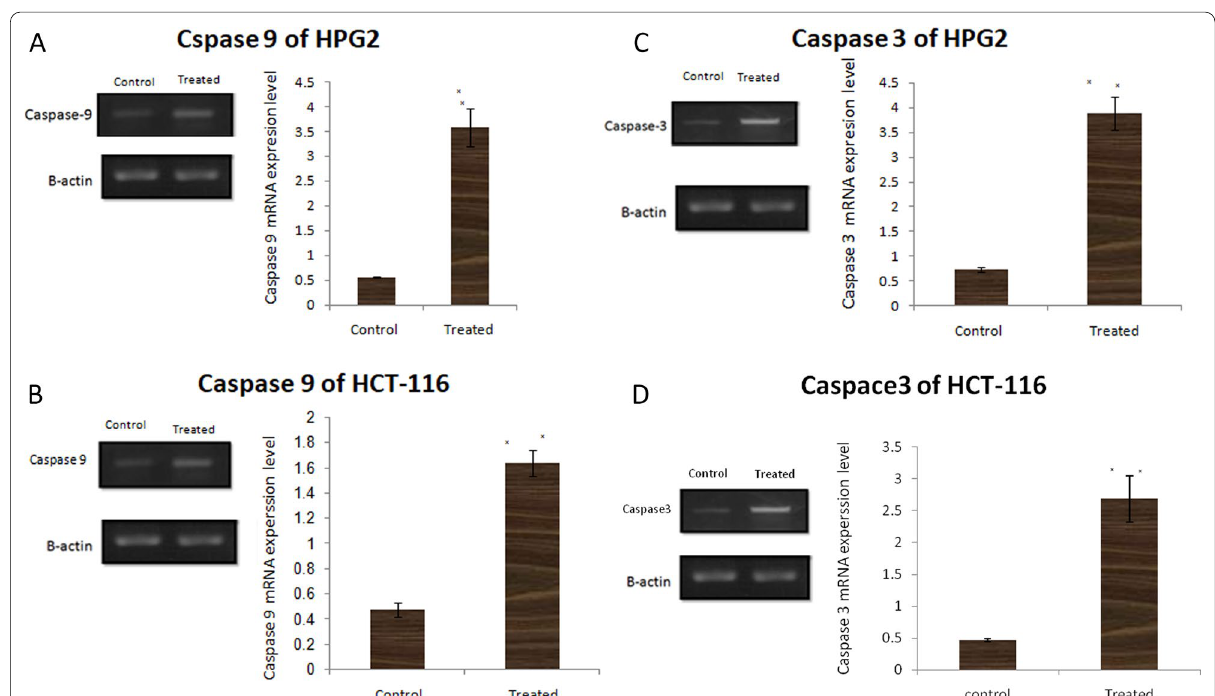
Fig. 7 PCR detected the expression of BCL2 in HepG2 and HCT‑116 cells after treatment with NSP where the internal control expressed by the β‑actin gene. In each illustrative experiment data represent means